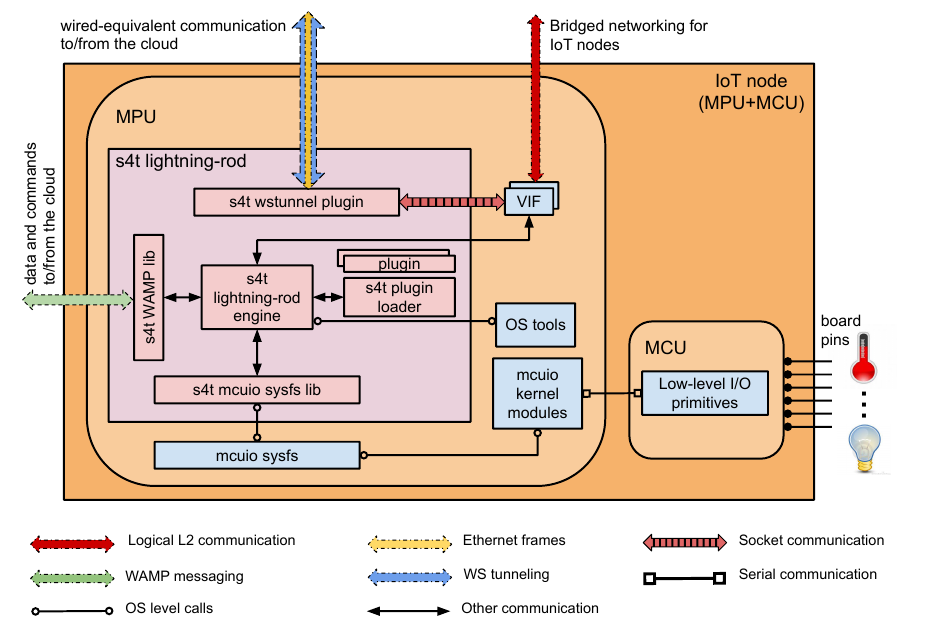
Figure 6. The device-side S4T virtual networking subsystem.